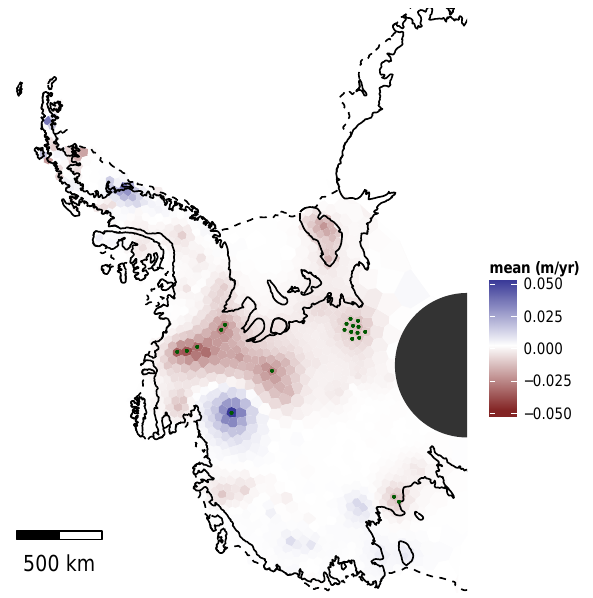
Figure 5. Height changes from firn compaction and elastic uplift of the crust for 2003–2009 in myr − 1 . Stippled points denote areas in which the mean signal is larger than the marginal standard devia-